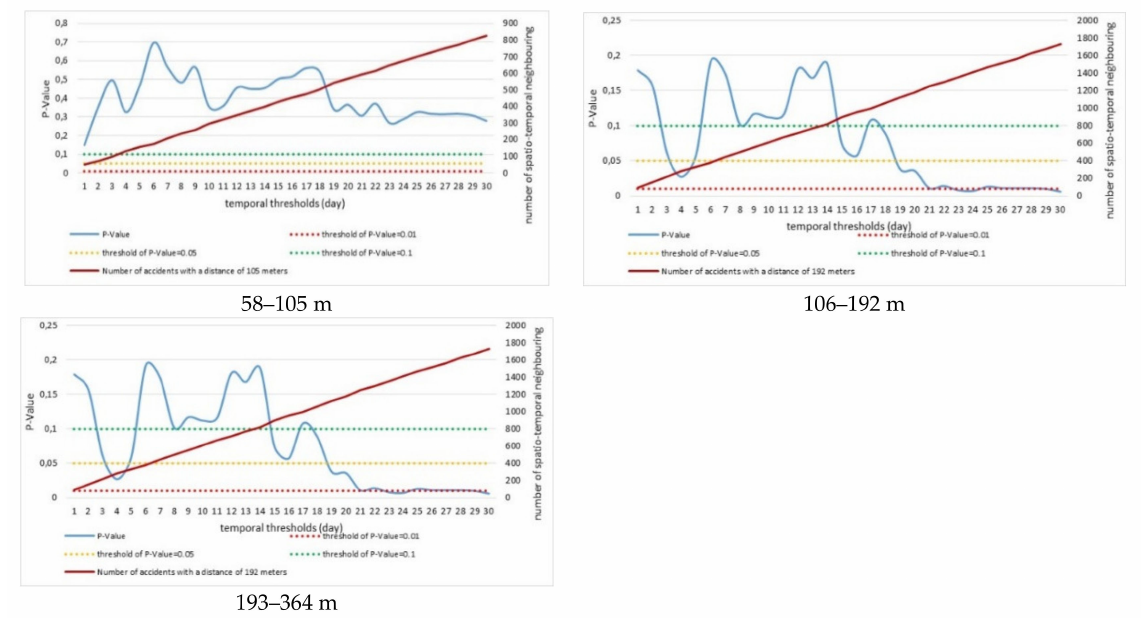
Figure 5. Analysis of spatiotemporal interactions in road accidents in Zanjan according to Knox test, by bandwidth range (m) and spatial threshold.